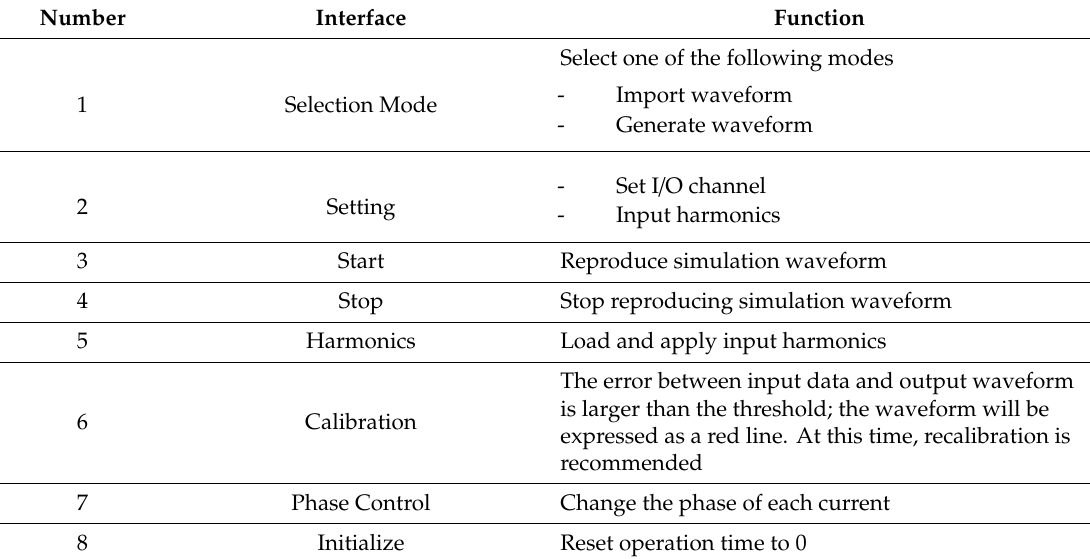
Table 1. Main interface configuration and functions.